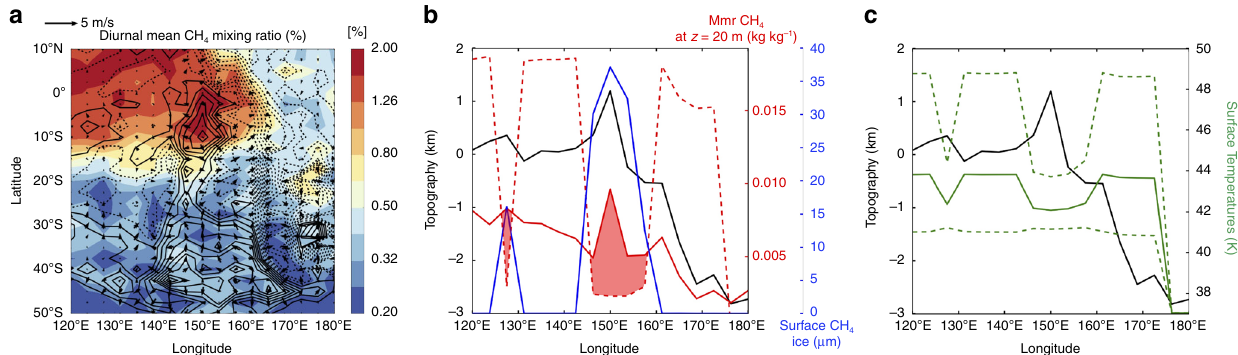
Fig. 3 Atmospheric CH 4 abundance and surface temperatures drive CH 4 condensation and accumulation on mountain summits. a Near-surface CH 4 atmospheric mixing ratio in Cthulhu as simulated by our model ( fi lled contours, in %) with arrows indicating winds at 5 m above the surface. b Cross- section of Cthulhu at 5°S showing the diurnal mean CH 4 mass mixing ratio (kg kg − 1 ) above the local surface (red solid line) and the diurnal mean CH 4 mass mixing ratio at saturation (red dotted line), as obtained in our simulation for July 2015; the topography; and the thickness of the surface layer of CH 4 ice (black solid line); and the thickness of the surface layer of CH 4 ice (about ∼ 40 µ m on top of Pigafetta Montes, blue solid line). The shaded areas indicate where there is saturation of CH 4 above the surface (in diurnal mean) that leads to condensation onto the surface. c Same cross-section showing the diurnal mean surface temperature (solid line) as obtained in our simulation. The diurnal minimal and maximal surface temperatures are also indicated (dotted lines). Colder daytime temperatures are obtained where CH 4 ice is present, due to the brighter surface (albedo positive feedback). Maps are shown in the Supplementary Figs. 1 and